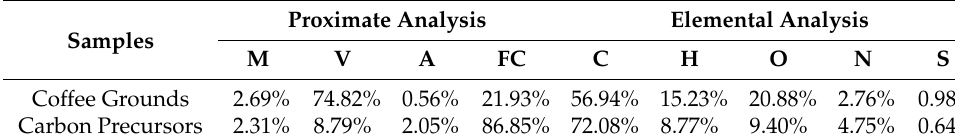
Table 1. Proximate analysis and elemental analysis of the samples.